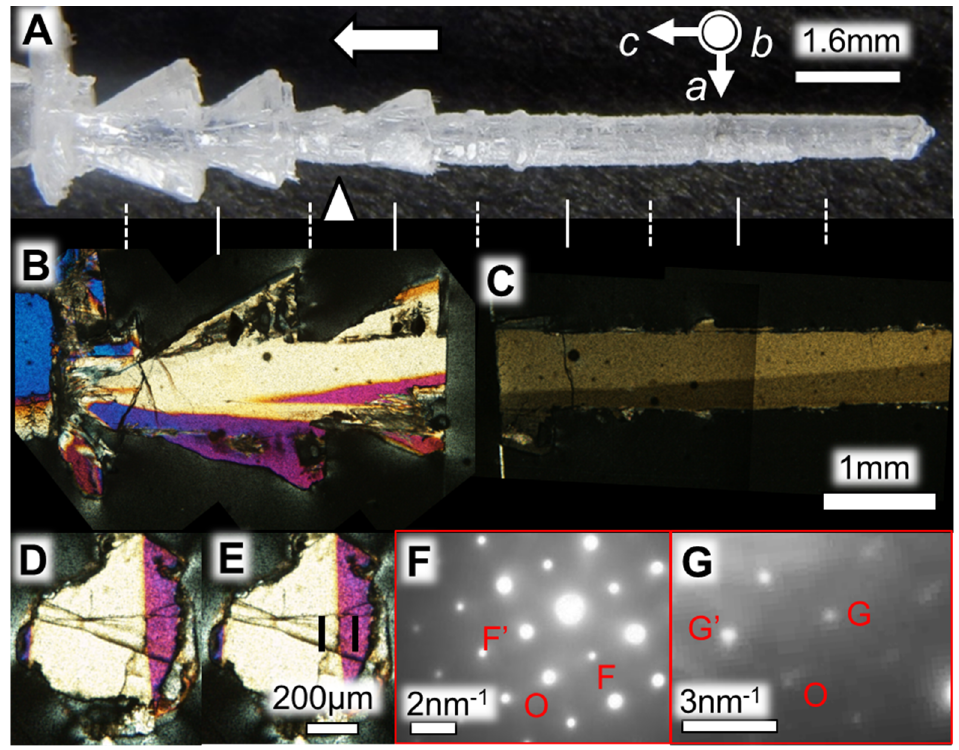
Figure 3. SBO crystal fibers grown at 400 V/cm: ( A ) external form of SBO crystal fibers; ( B , C ) po- larized optical microscope image of the SBO crystal taken under crossed Nicols; ( D ) cross-sectional view of the crystal fiber at the white-arrowhead position of ( A ) (a portion between ( B , C )); ( E ) parts processed by FIB for the TEM/SAED observation (black lines); ( F ) electron diffraction pattern of the domain at the left of ( E ); ( G ) electron diffraction pattern of the domain at the right of ( E ). Symbols in ( A ) correspond to the crystallographic orientation of seed crystals. A white arrow shows the pulling-down direction. Alternating timing of electric fields corresponds to solid lines (electrodes in the melt; +; growth fronts: − ) and dashed lines (electrodes in the melt: − ; growth fronts: +).